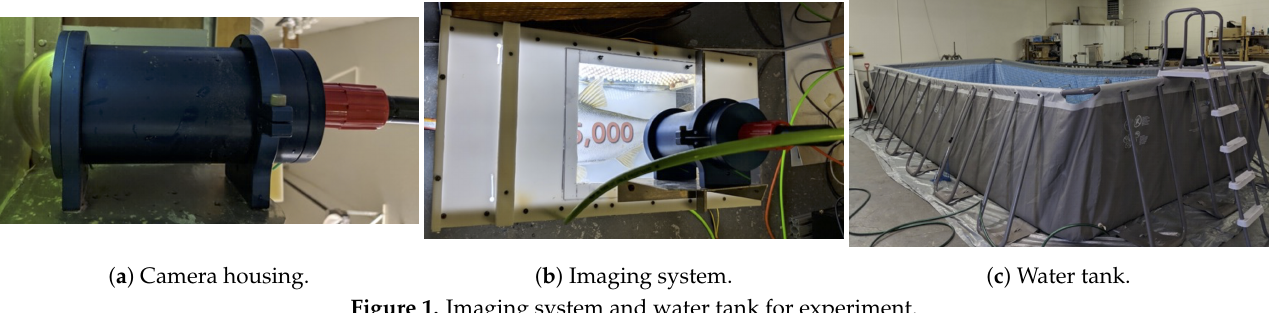
Figure 1. Imaging system and water tank for experiment.